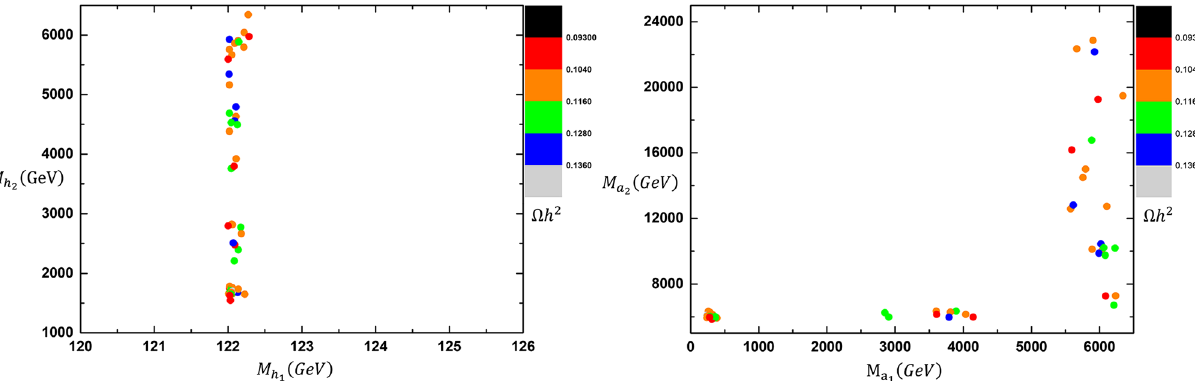
Fig. 4 The masses of the Higgs scalars with d ≈ 1 . 8. All samples satisfy the constraints